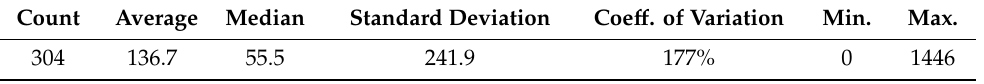
Table 1. Basic descriptive statistics for the number of meetings during the analyzed promotional events. Count Average Median Source: own study.